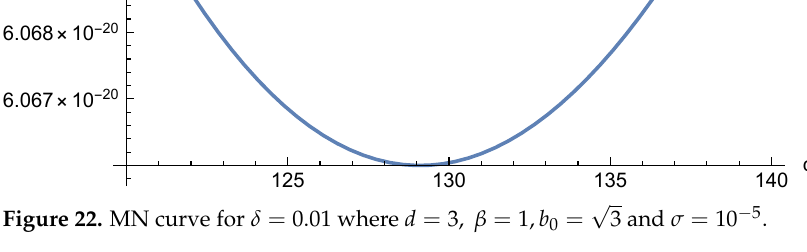
Figure 22. MN curve for δ = 0.01 where d = 3, β = 1, b 0 =